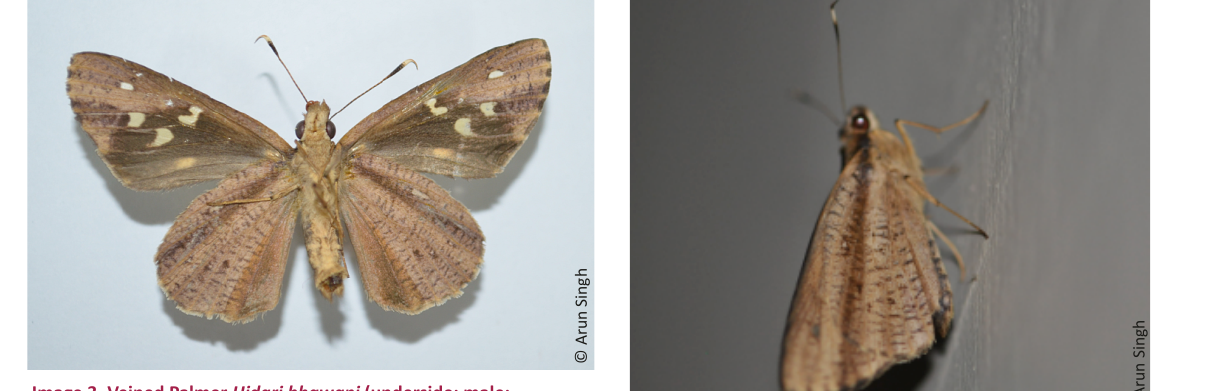
Image 3. Veined Palmer Hidari bhawani (underside; male; 26.iii.2014-RFRI coll.)